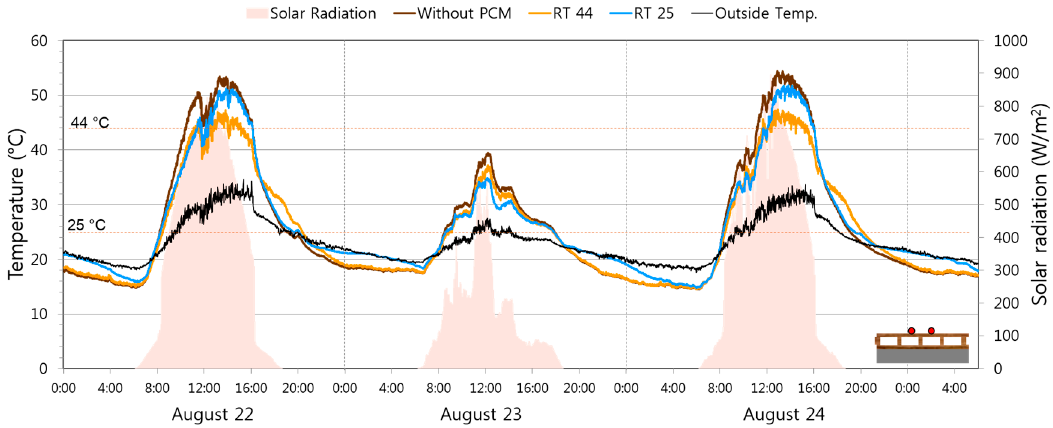
Figure 7. Outer surface temperatures of the plates with PCMs with different melting temperatures.